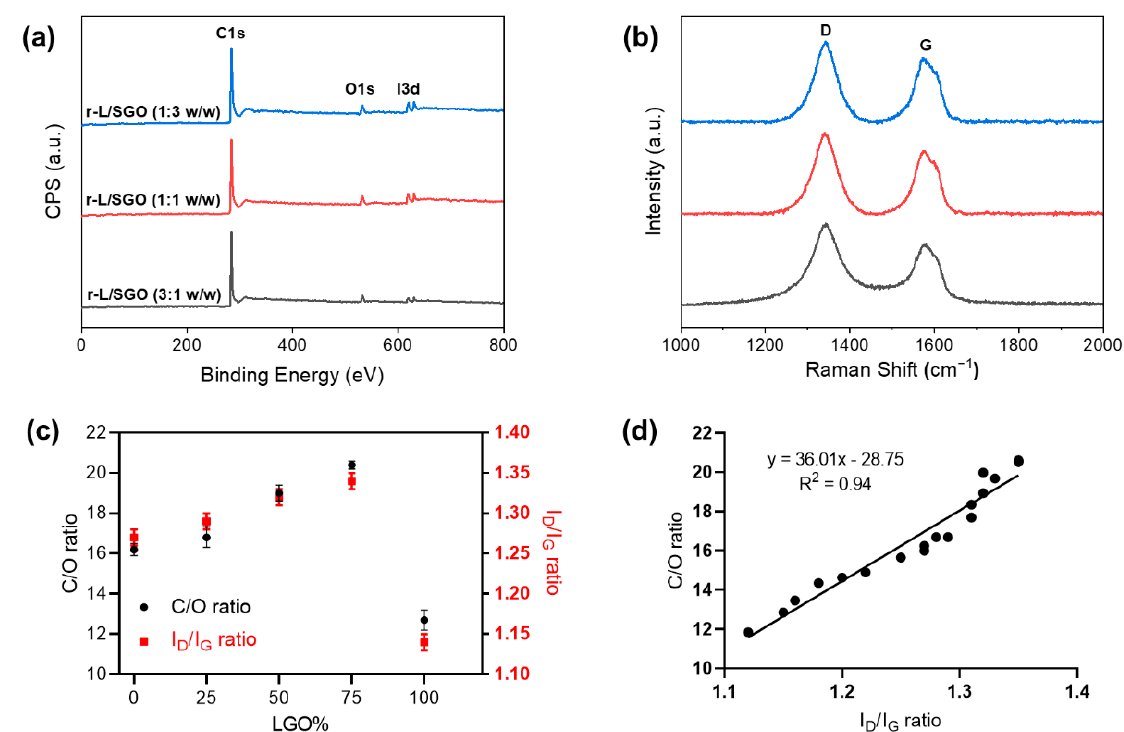
Figure 4. Characterizations of rGO films prepared with mixed LGO and SGO at different ratios. All rGO film prepared with HI acid as reductant. ( a ) XPS spectra; ( b ) Raman spectra; ( c ) dependence of C/O and I D /I G ratios of rGO films on LGO percentage used in the film preparations. All error bars represent standard error of mean, n = 3. The solid line in ( c ) represents a linear regression fit. ( d ) Correlation between C/O ratio and Raman I D /I G